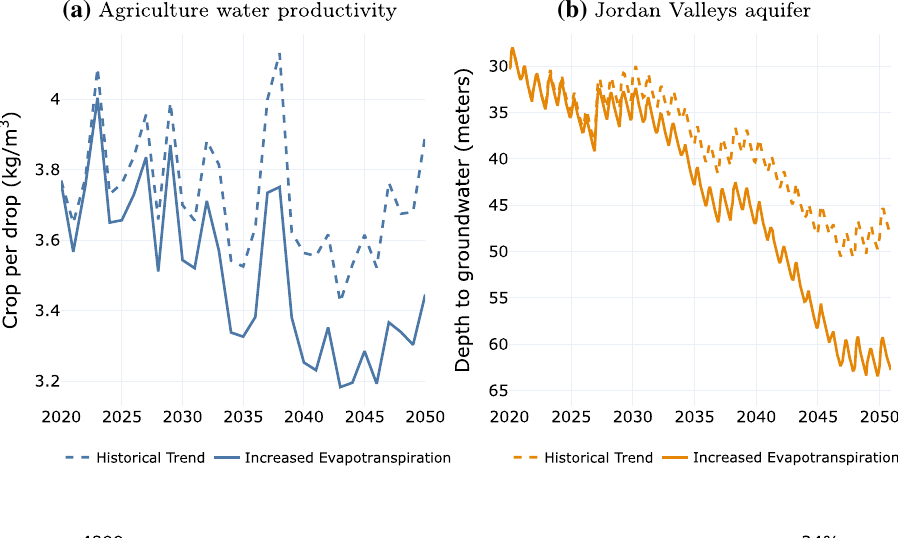
Fig. 5 Energy requirements for the different water uses in the no intervention scenario for two climate futures (left axis: energy demand in the Historical climate conditions; right axis: percentage change in demand due to increased